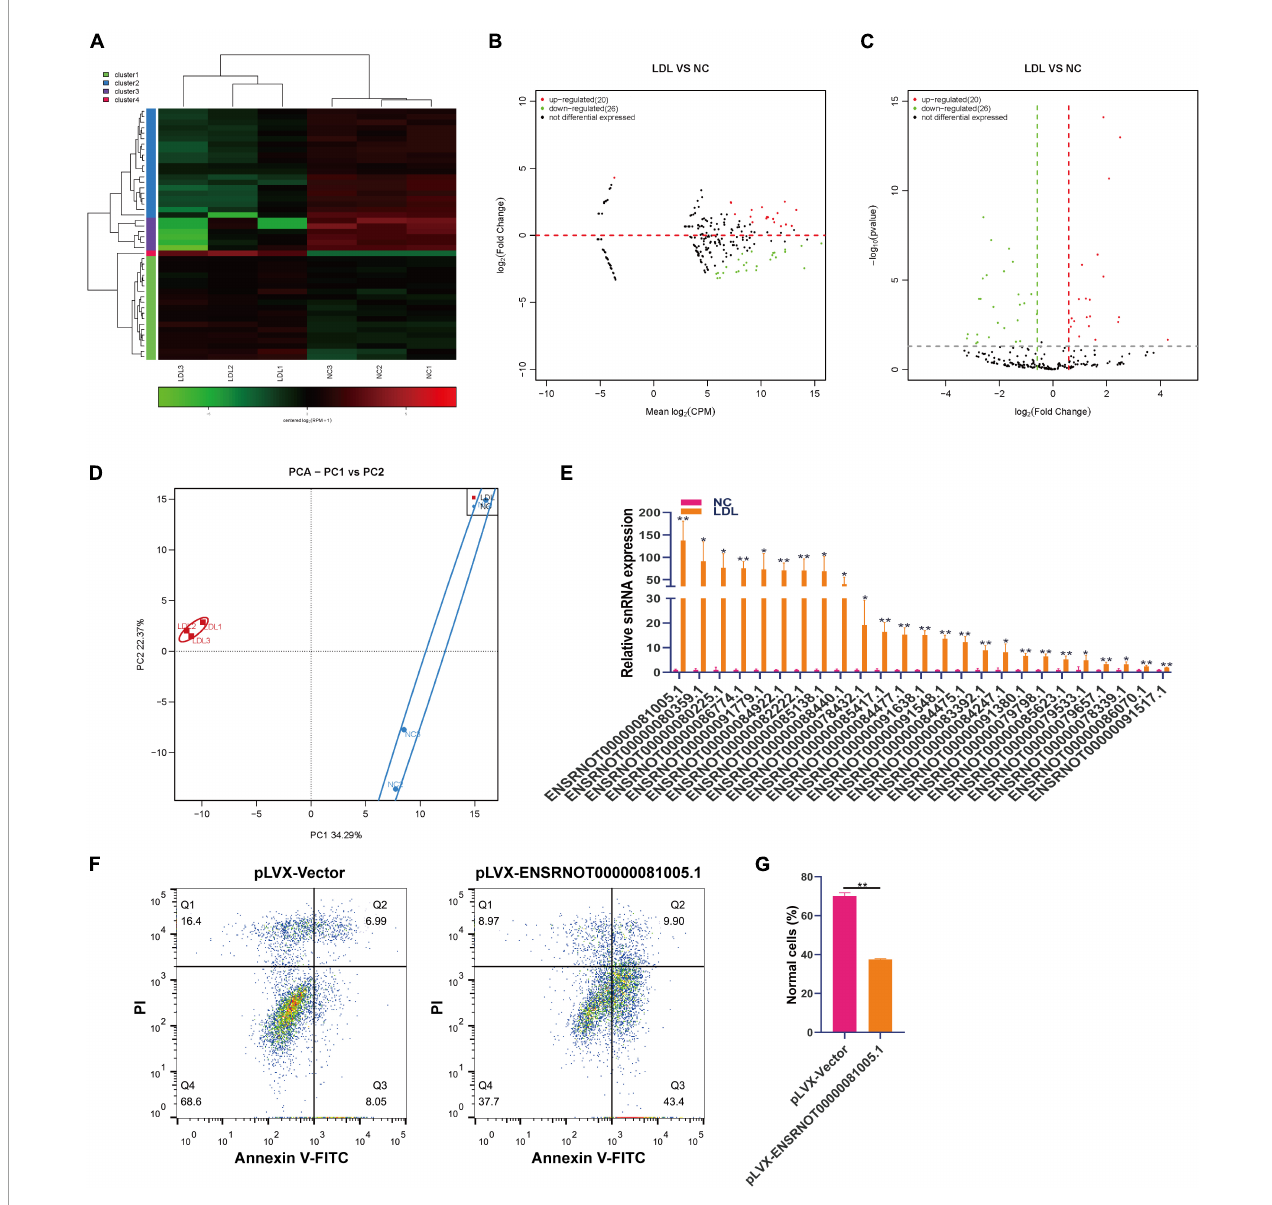
FIGURE3 Differential expression of snRNA in rat endothelial cells treated with ox-LDL. Heatmap (A) , MA map (B) , and volcano map (C) show the expression of snRNA in rat endothelial cells with ox-LDL treatment, n = 3. (D) PCA showed the expression of snRNA in rat endothelial cells with or without ox-LDL treatment, n = 3. (E) qPCR detected the expression of snRNA in rat endothelial cells with or without ox-LDL treatment. (F) Flow cytometry assay of cell apoptosis after treatment with pLVX-ENSRNOT00000081005.1. (G) Quantification of normal cells according to flow cytometric analysis. For the statistical analysis, three independent experiments were conducted. * p < 0.05, ** p <